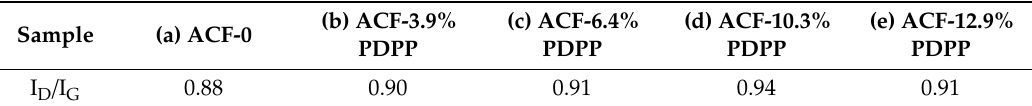
Figure 3. ( A ) XRD patterns and ( B ) Raman spectra of ( a ) ACF-0; ( b ) ACF-3.9% PDPP; ( c ) ACF-6.4% PDPP; ( d ) ACF-10.3% PDPP; and ( e ) ACF-12.9% PDPP. Table 1. I D / I G data from Raman spectra of ( a ) ACF-0, ( b ) ACF-3.9% PDPP, ( c ) ACF-6.4% PDPP, ( d )